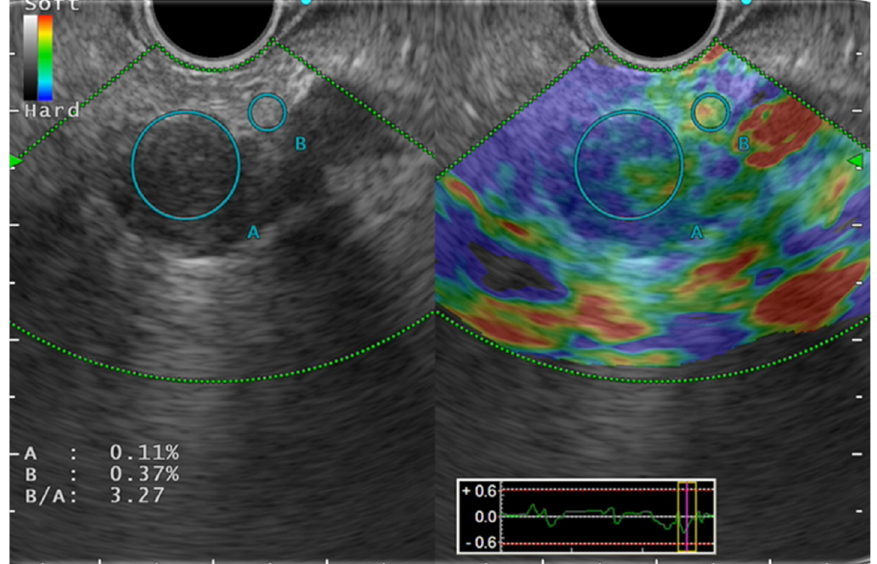
Figure 1. Strain